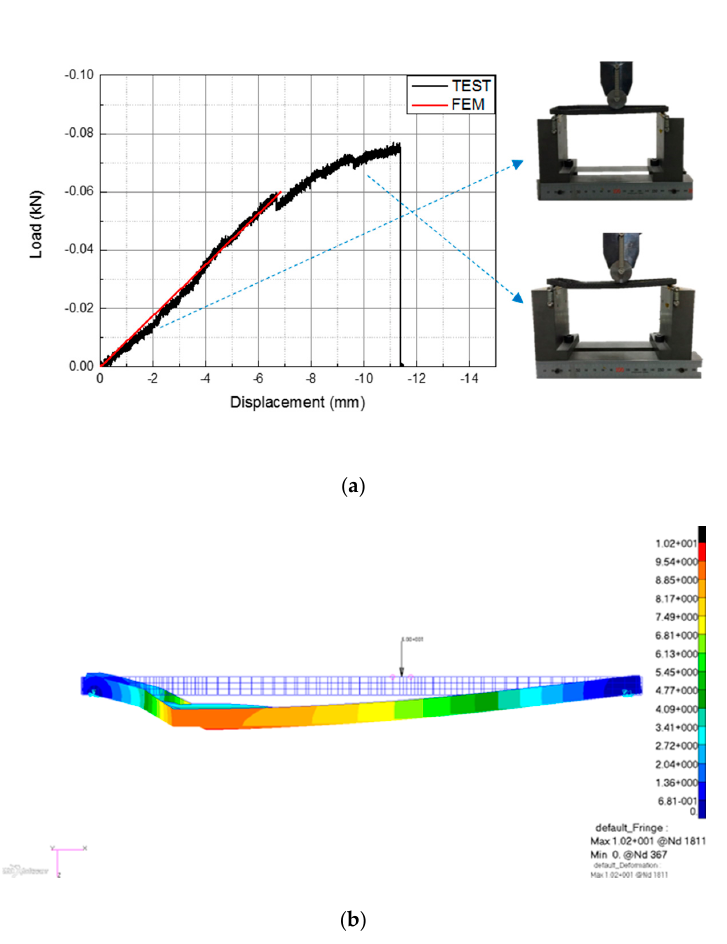
Figure 22. The rib bending test and analysis results: ( a ) testing results and ( b ) numerical results.